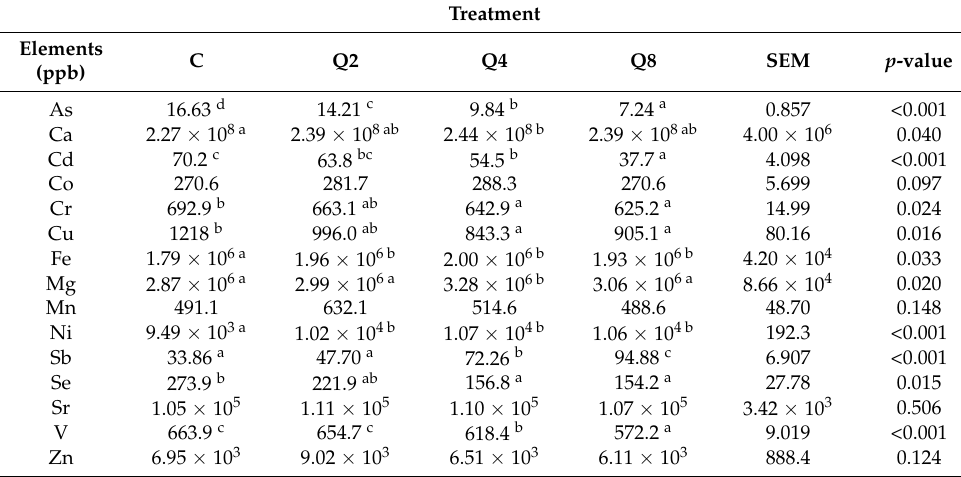
Table 3. The effect of dietary supplementation with quercetin on selected trace- and macro-elements concentrations in laying hens’ egg shell ( n =